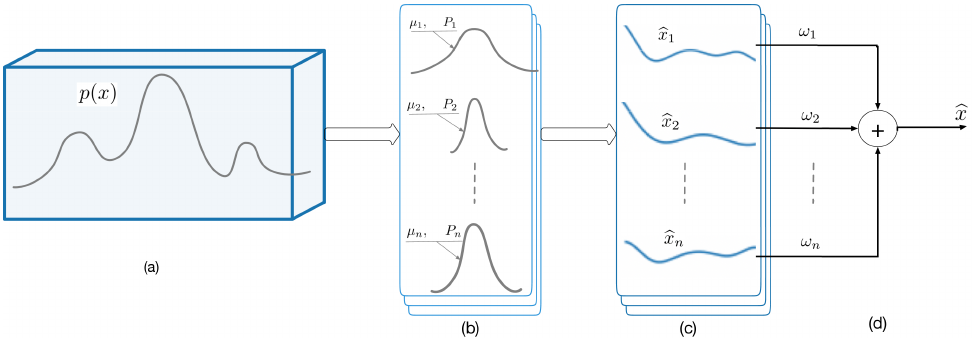
Figure 1. A flowchart of the Gaussian mixture filter. ( a ) The system noise is a complicated one with multiple Gaussian components. ( b ) The complex Gaussian noise of the system is decomposed into several standard Gaussian noises P i , i = 1,2,...... n . ( c ) The state (cid:98) x i is estimated based on each Gaussian noise. ( d ) The state estimation result based on the complex mixed high noise is obtained by using the estimated result and the